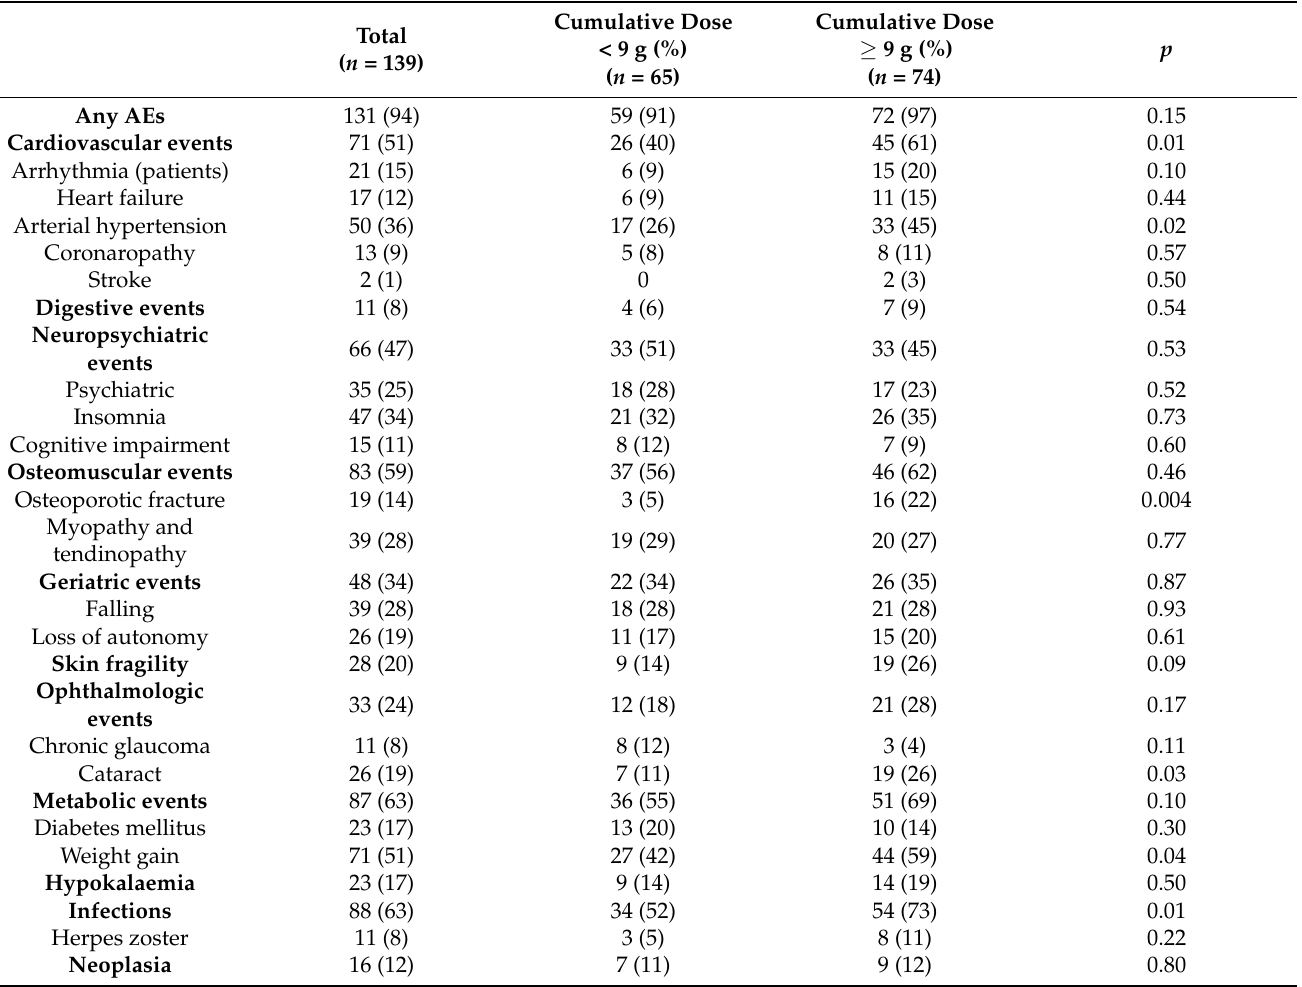
Table 2. Glucocorticoid-related adverse events in GCA patients according to whether they received less than or more than 9 g of GC cumulative doses.